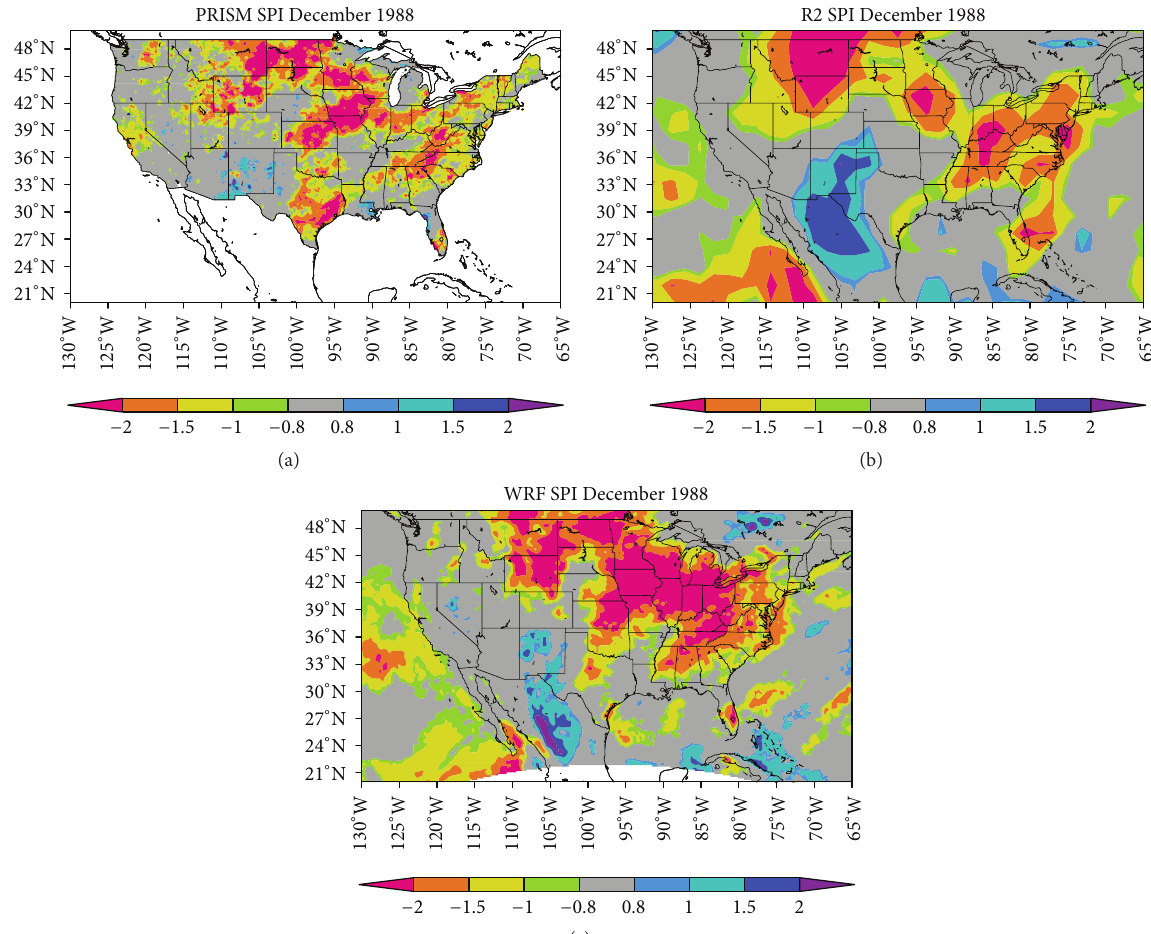
Figure 6: 12-month SPI ending in December 1988 calculated from (a) PRISM, (b) R2, and (c)